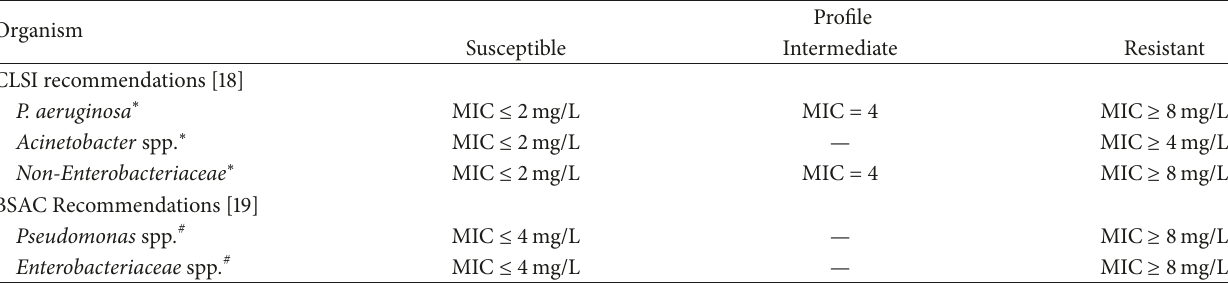
Table 1: Susceptibility breakpoints of polymyxins for major pathogens.